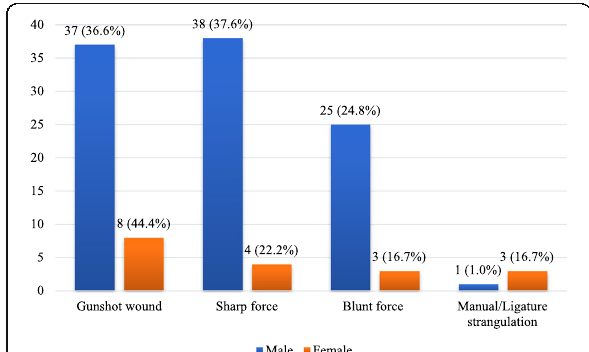
Fig. 7 Percent of homicides by sex and type of force